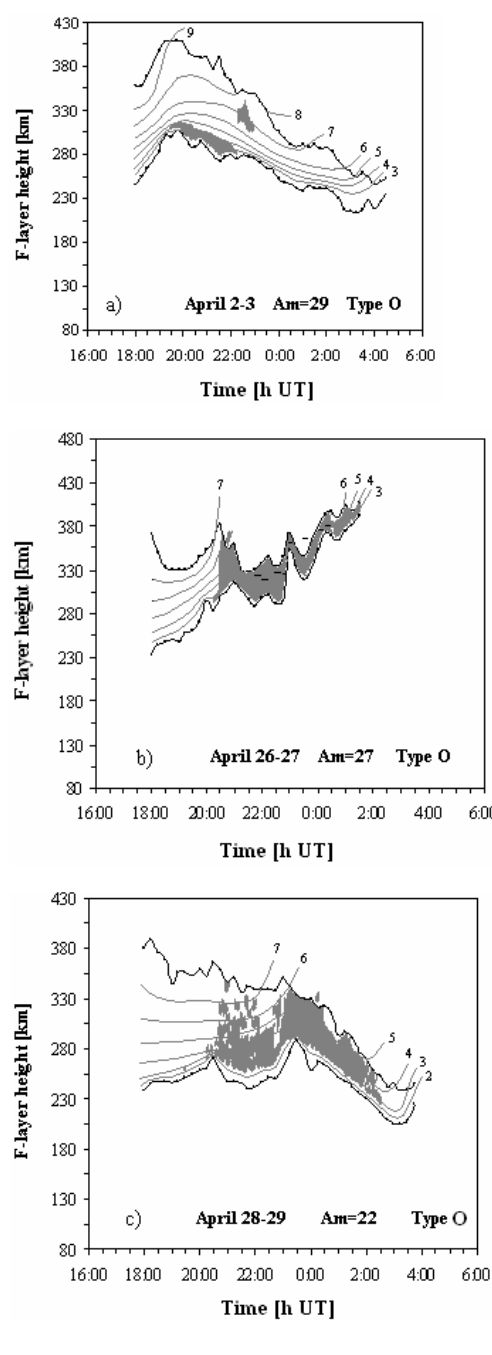
Fig. 10. ESF behaviour on O-type F-layers for three nights, (a) 2–3 April, (b) 26–27 April, (c) 28–29 April. On 26–27 April (Fig. 10b) the thin initial trace (b-type echo) indicates a locally generated ESF event. On 2–3 April (Fig. 10a) and 28–29 April (Fig. 10c) the maps exhibit two isolated clouds slowly descending and patchy pat- terns before 22:30UT respectively, both with evidence of non-local